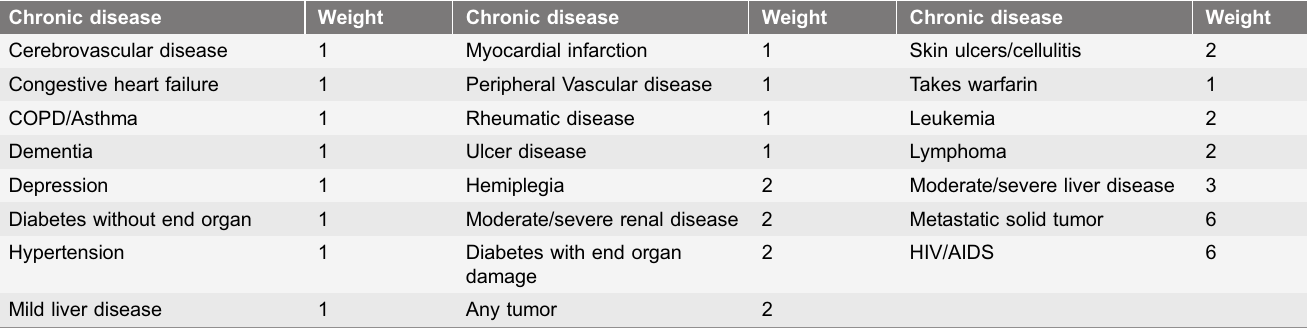
Table 1. Different weights assigned for specific conditions in the comorbidity index. Chronic disease Weight Chronic disease